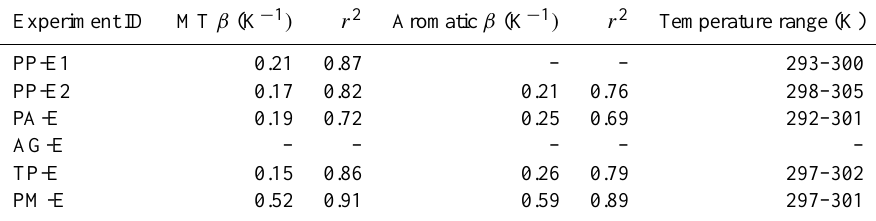
Table 2. Summary of activity adjustment factors for total monoterpenes and total aromatics that were calculated from pre-treatment emis- sions. Dashes indicate that no relationship could be established between temperature and emission rate for that experiment.